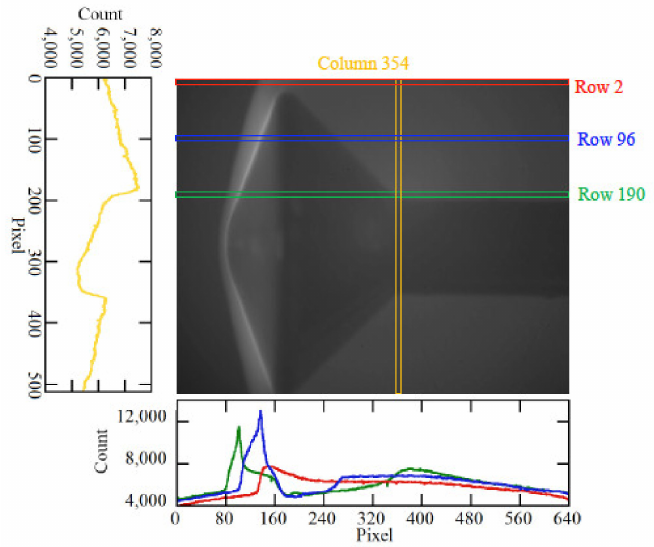
Figure 34. Spatial distribution of IR radiation intensity at 7.6 km/s (from